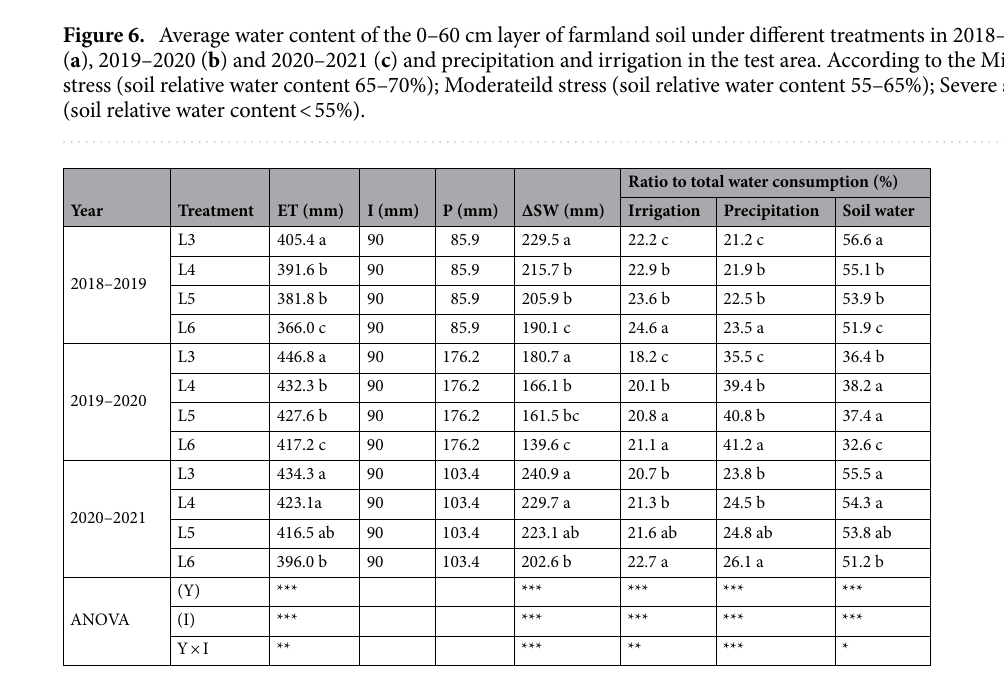
Table 4. Effects of irrigation time on total water consumption (ET), soil water consumption (ΔSW) and their water consumption ratios during the 2018–2021 wheat growing seasons. *, **, and *** indicate significant effects at P < 0.05, P < 0.01 and P <